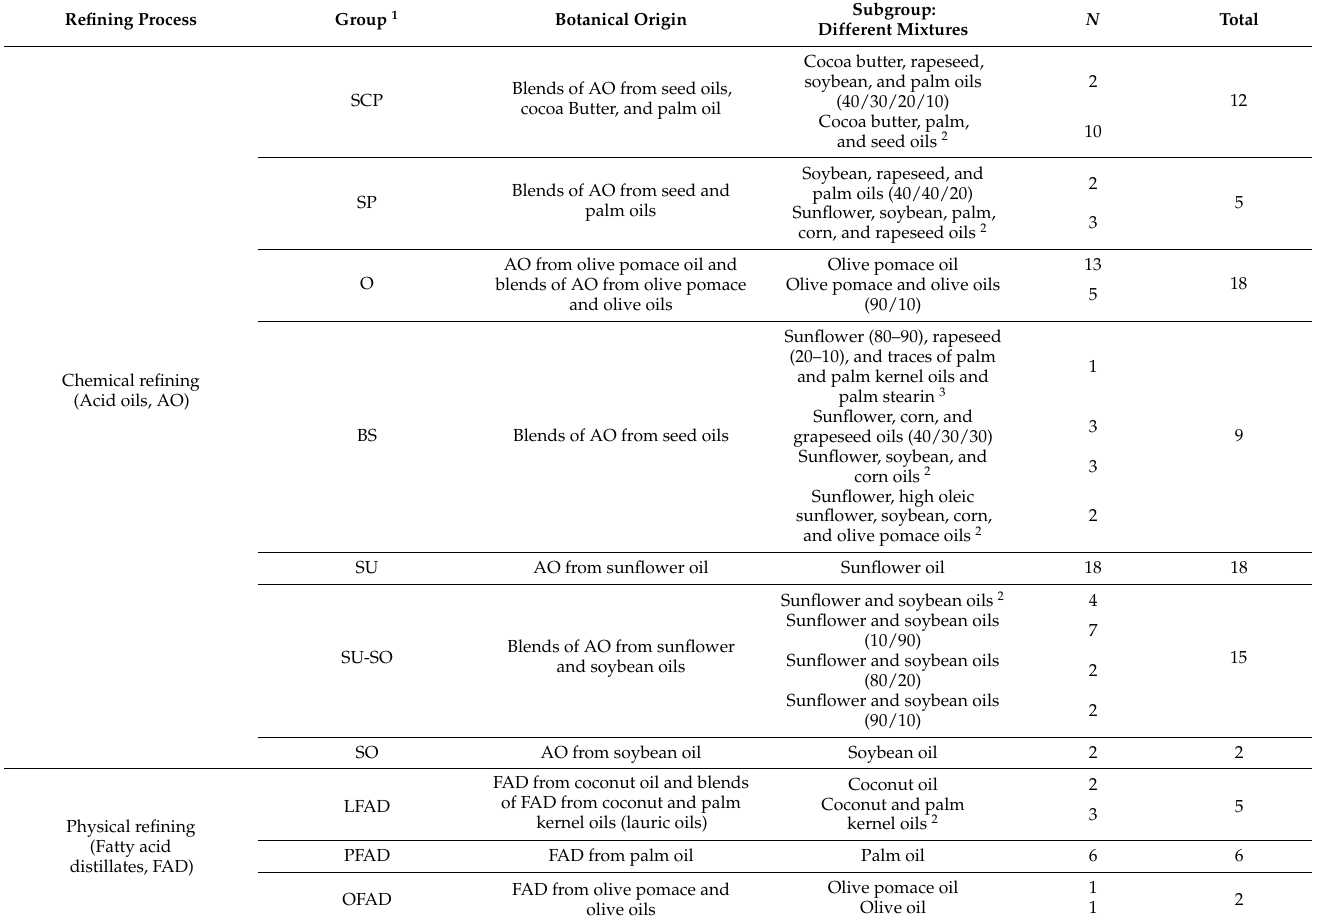
Table 1. Samples’ classification according to the refining process and botanical